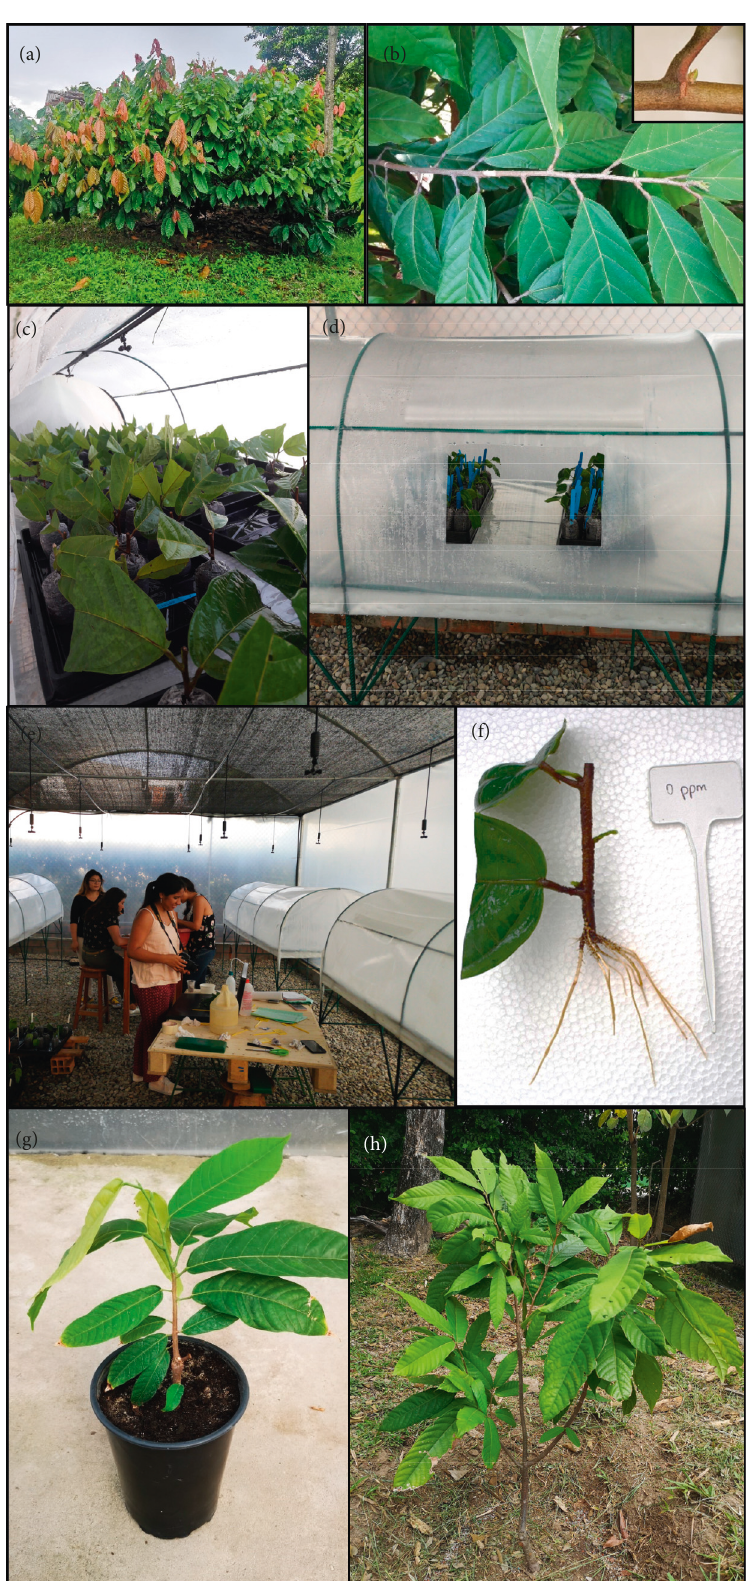
Figure 1: Process of rooting of T. cacao cuttings. (a) Selected tree. (b) T. cacao shoot with axillary buds (inner box). (c) Cuttings placed in Jiffy pellets with and without IBA. (d, e) External view of a mini-tunnels. (f) Root system in cutting after 40 days of treatment. (g) Potted T. cacao cutting, 90days old. (h) T. cacao plant established in the